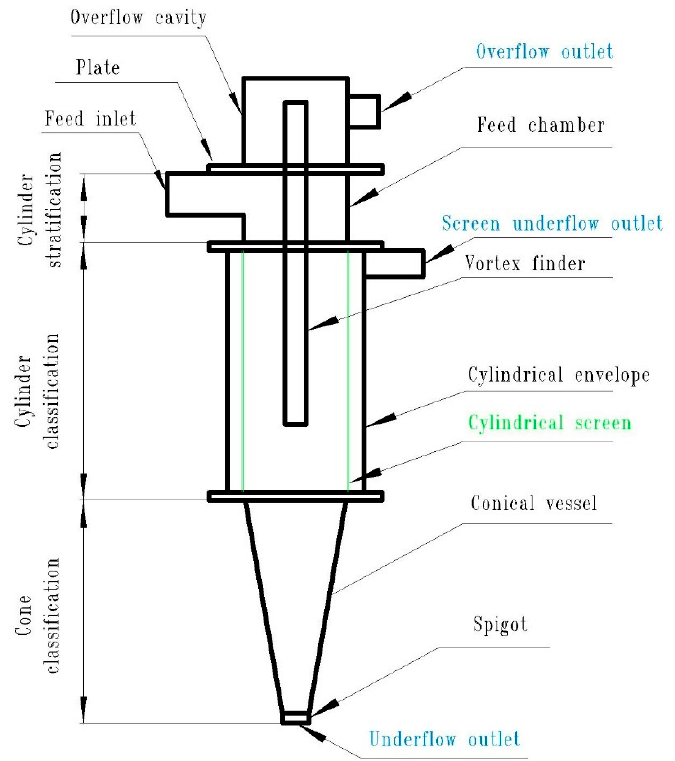
Figure 1. Schematic diagram of the three products hydrocyclone (TPHS).